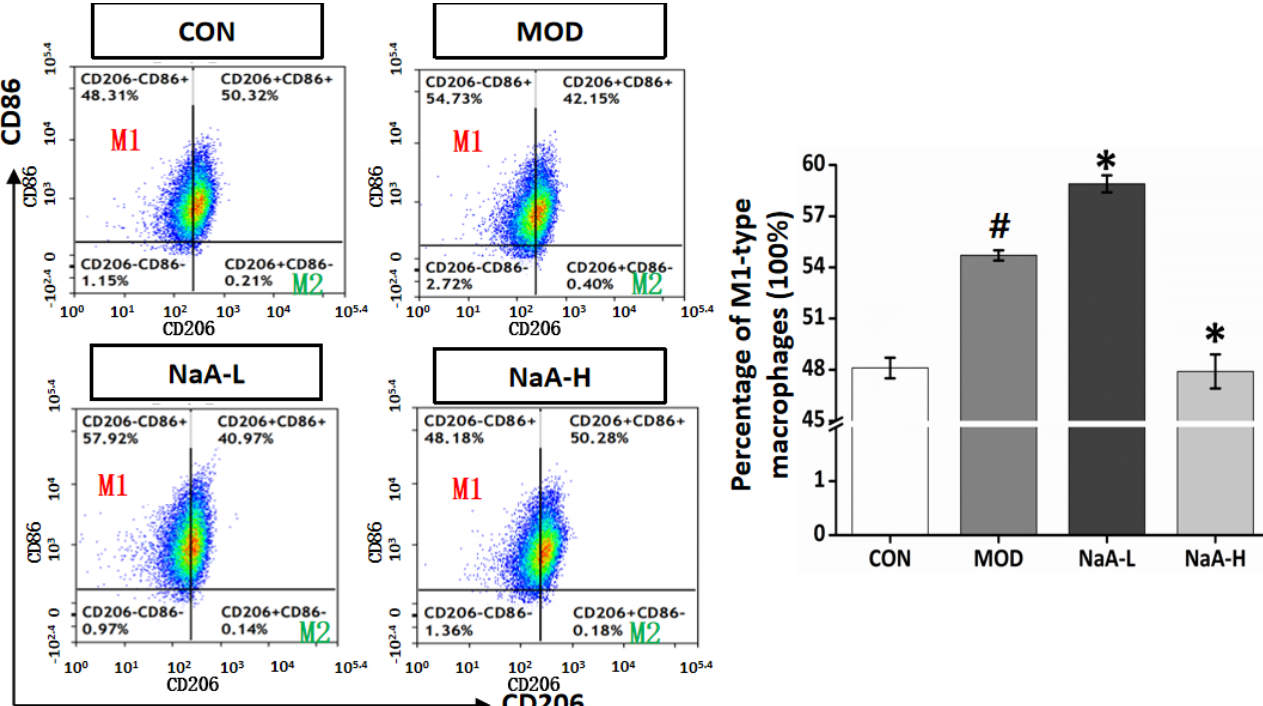
Figure 3. NaA alters the ratio of M1 macrophages in RAW264.7 stimulated by LPS. RAW264.7 cells were pretreated with NaA (0.1, 2 mM) for 18 h before treatment with LPS (100 ng/mL). Cells were harvested at 6 h of LPS incubation for further flow cytometry analysis. For all bar graphs, data are the mean ± SD, # p < 0.05, as compared with CON, and * p < 0.05, as compared with MOD. The significant difference was assessed using the one ‐ way ANOVA followed by LSD post ‐ tests. Control group (CON), group model cell treated with an LPS (MOD), 0.1 mM sodium acetate group (NaA ‐ L), 2 mM sodium acetate (NaA ‐ H), arbitrary unit (AU).